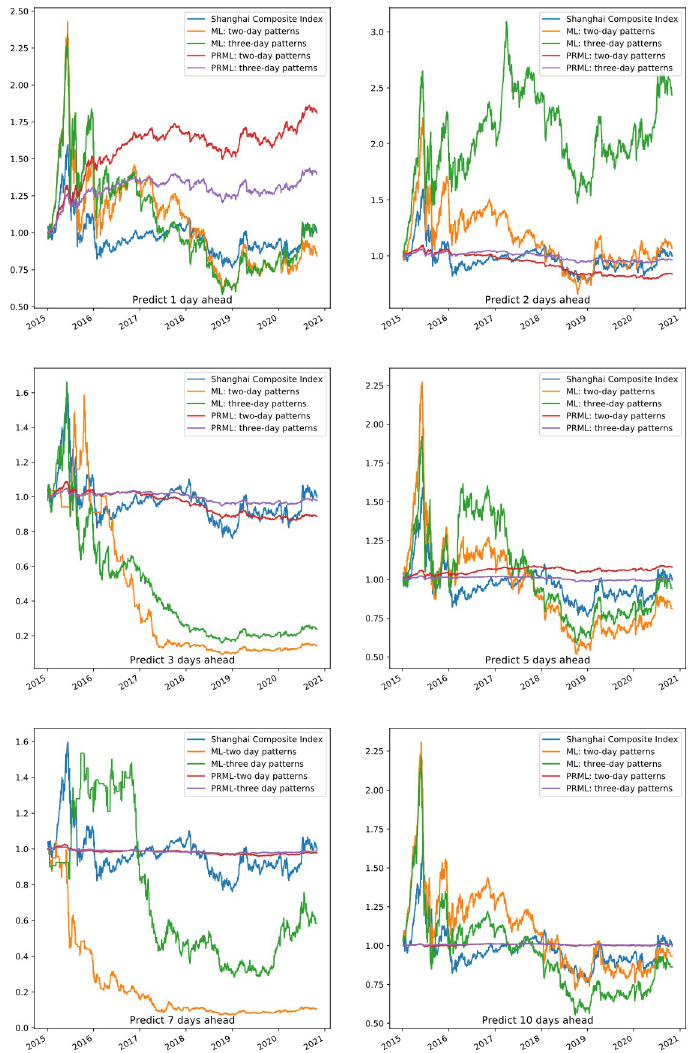
Fig 7. Portfolio forecasting performance of 1, 2, 3, 5, 7, 10 days ahead: PRML vs. ML.